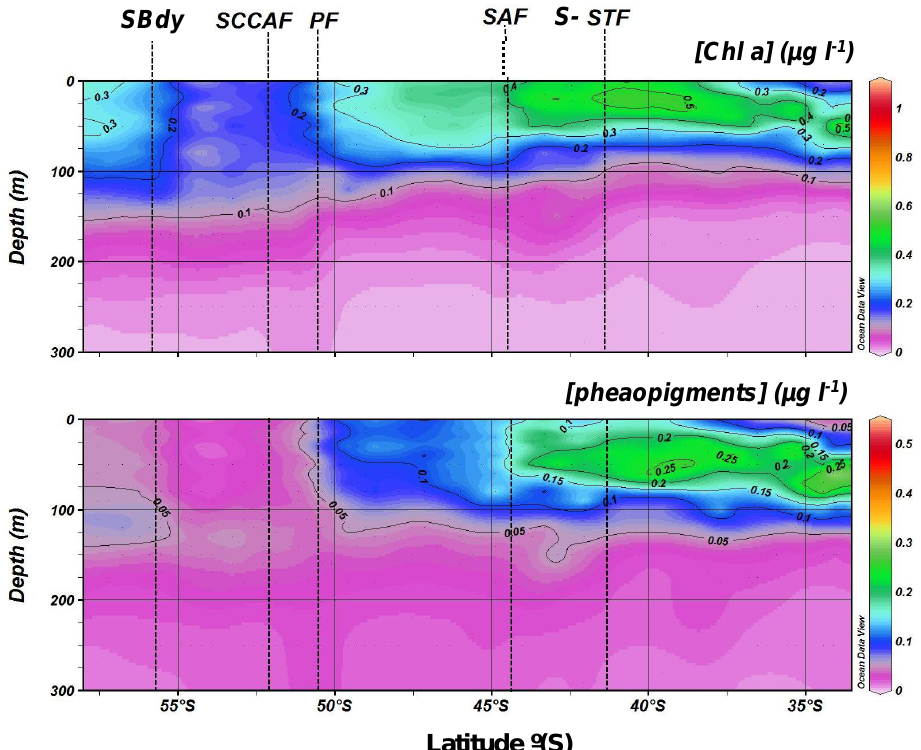
Fig. 3. Contour plot of ammonium concentrations (NH + prepared using Ocean Data View (Schlitzer, 2012).